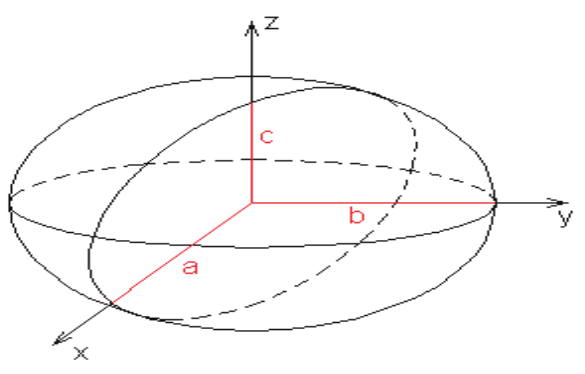
Fig. 1a. Rotating ellipsoid. Fig. 1b. Rotating ellipsoid.